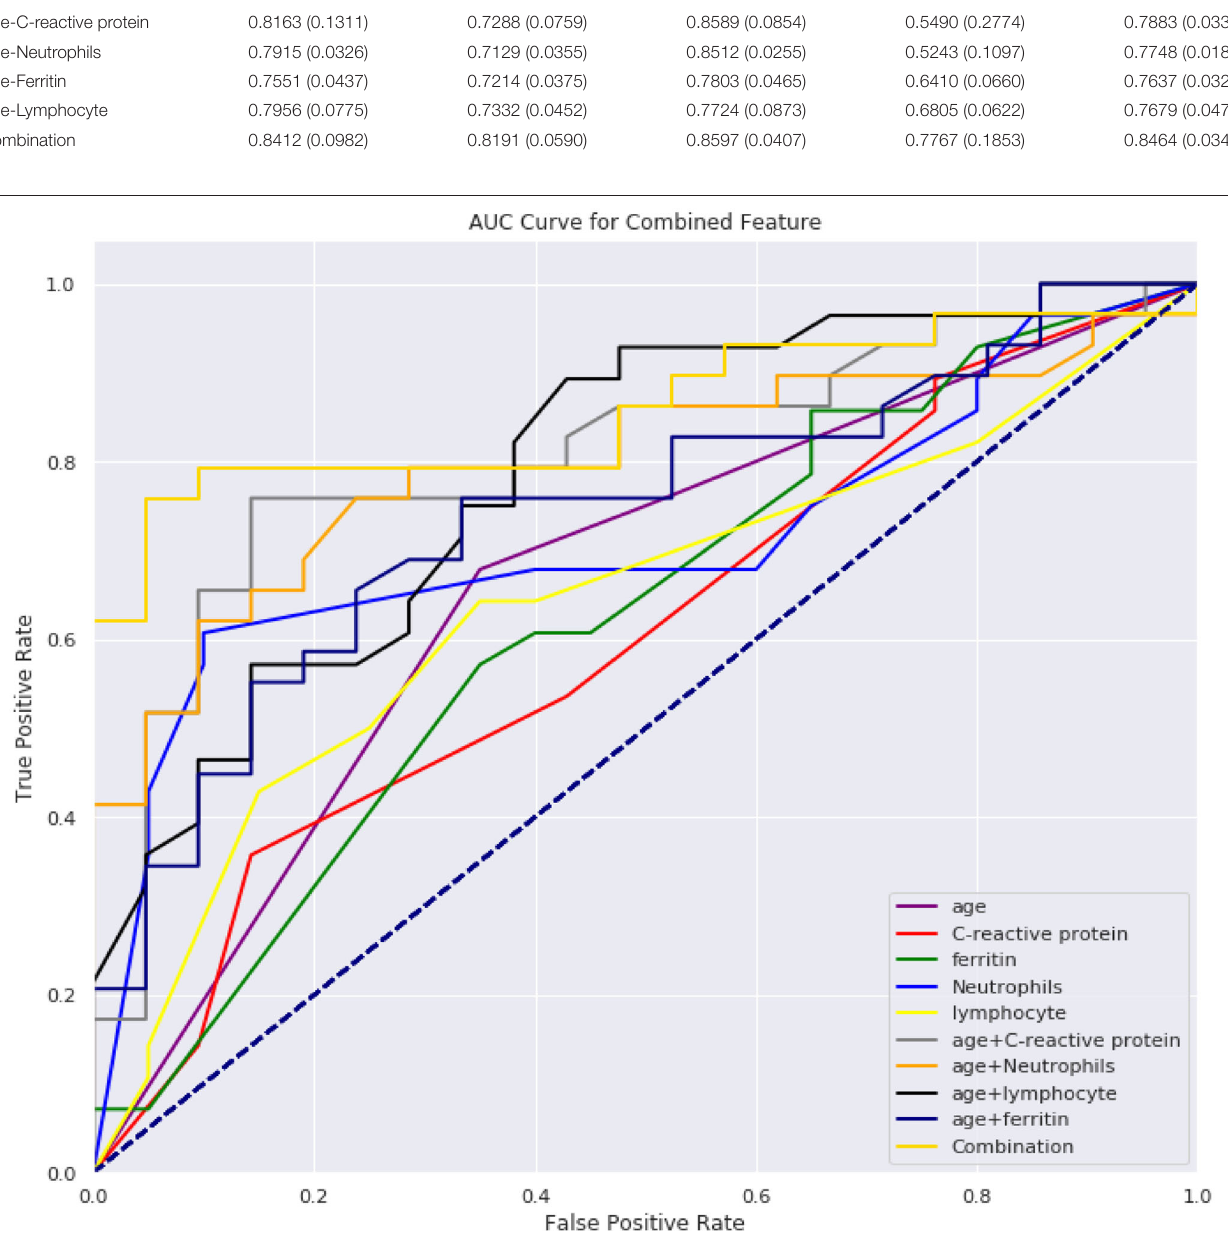
FIGURE 4 | AUC score for all